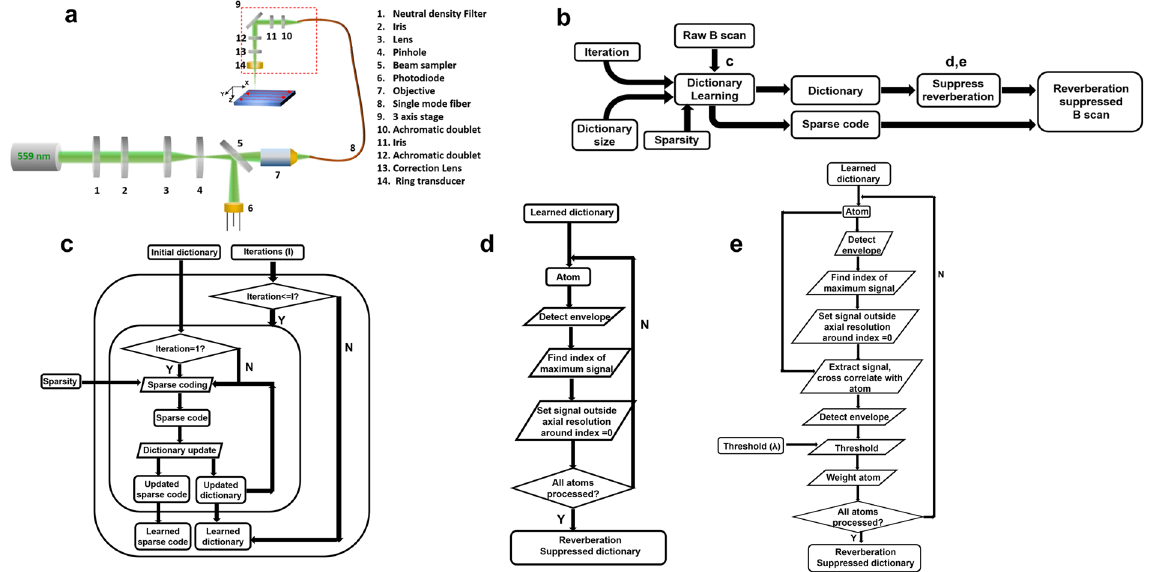
Figure 2. ( a ) Schematic of the PAM setup. ( b ) Reverberation suppression procedure. The white arrows indicate reverberant artifacts and the red arrows indicate true signals of small interfaces causing the reverberation and P represents a matrix, where each column is the transducer receive mode impulse response shifted axially to the spatial location of the transient pressure ⋃ = Note that it is not feasible to measure S experimentally, given the heterogeneity of tissue and structures within the body. It follows from Eqn. (6) that if the signal at a given depth in the tissue contains only the true signal but no reverberation, then | | = S 1 . In this case, the signal at this point is only represented by a single copy of the trans- 0 ducer impulse response shifted to that point. PAM data are acquired as a two dimensional ensemble of A-lines by raster scanning the region of interest with coaxially and confocally aligned dual foci 16 (Fig. 2a). An A-line is a com- bination of signals and reverberant echoes from multiple sources over the imaging depth. This can be represented as a sparse linear combination of basis vectors (Supplementary section S1). The number of possible basis vectors exceeds the dimensionality of the A-line, which makes this basis over-complete and consequently a vector of weights that combines these basis vectors is sparse. DL algorithms can adaptively learn over-complete bases and sparse weighting vectors simultaneously from the data. Once the basis is computed, it follows from Eqn. (6) that if we reduce the contribution of the reverberant responses in S to just the signal, i.e. with = S 1 . Then the reverberation 0 is suppressed. The complete reverberation suppression algorithm (Fig. 2b) is illustrated in pseudo-code as follows.